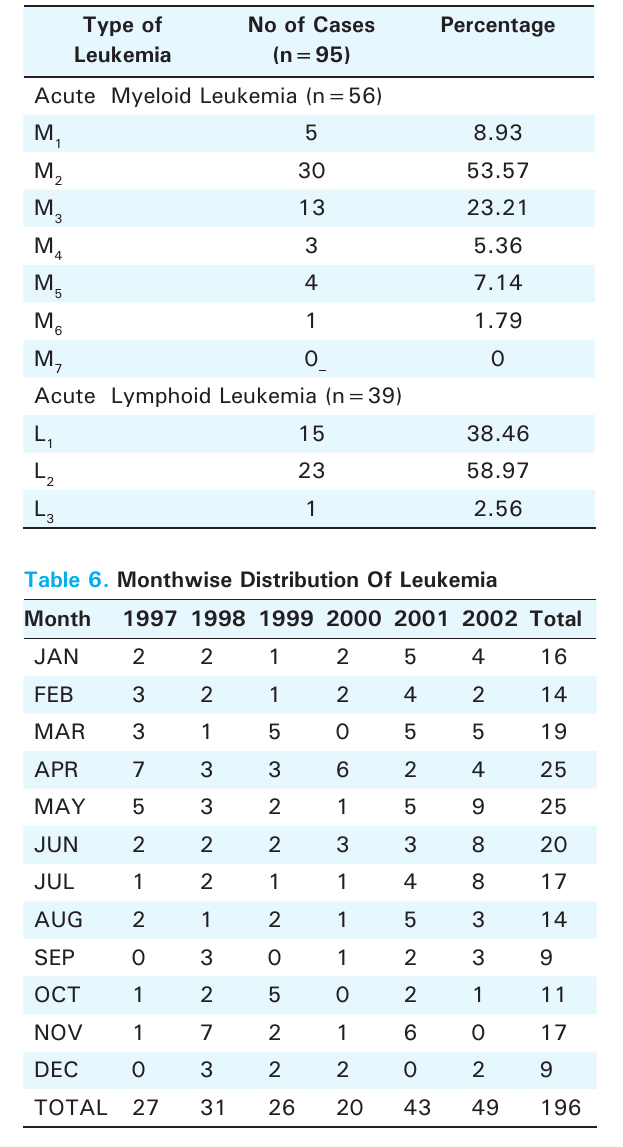
table 5. Distribution of Acute Leukemia (fAb Classification)